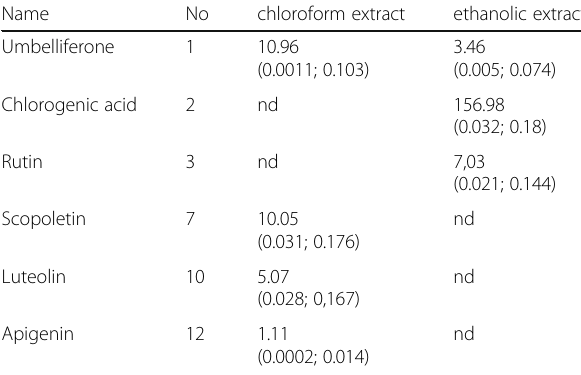
Table 1 HPLC- DAD analysis. The content of identified compounds in the extracts from A. gmelinii Weber ex Stechm. per gram of plant material used [mg/g] and (SD;